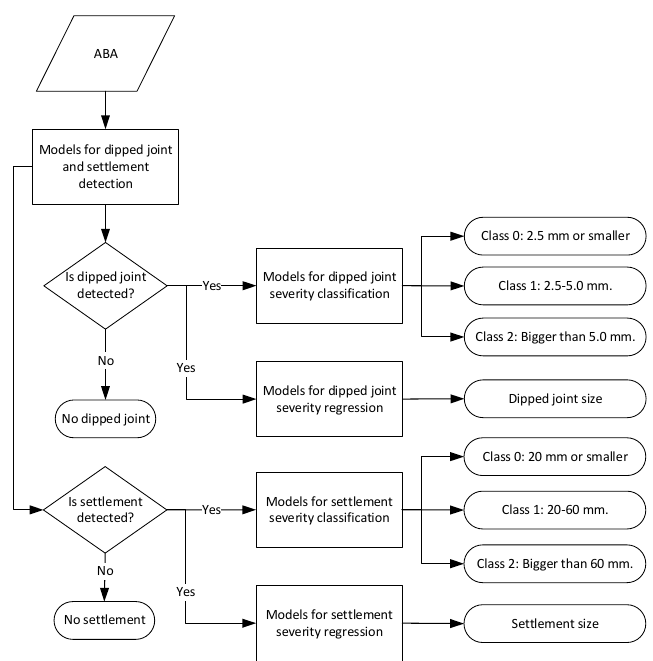
Figure 3. Workflow of the machine learning models.